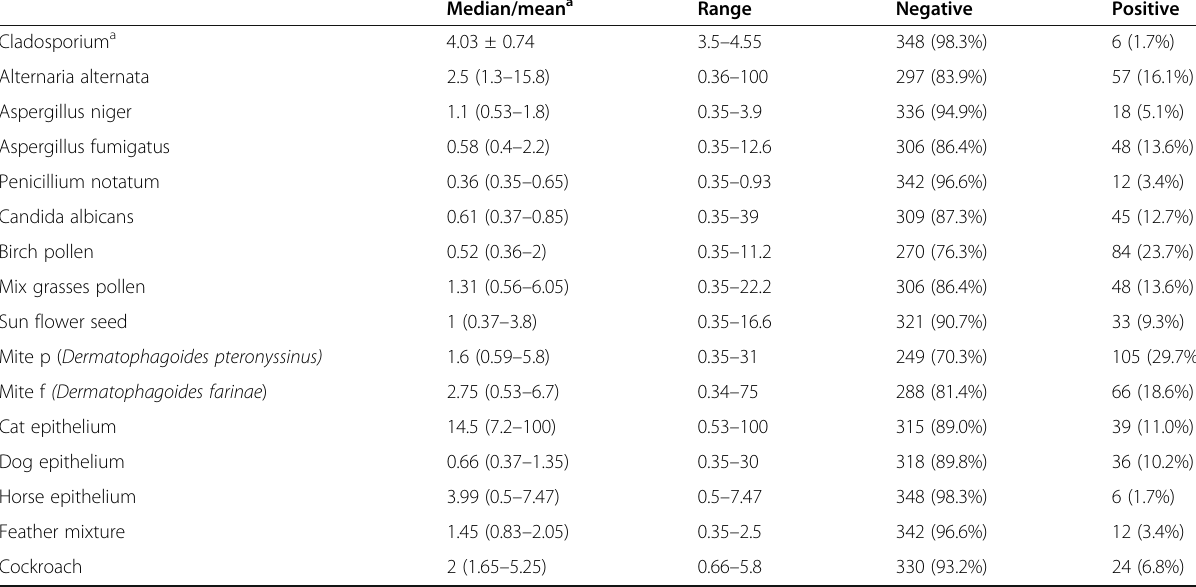
Table 2 Prevalence of positive-specific IGE to common aeroallergen among allergic rhinitis patients Median/mean a Range Negative